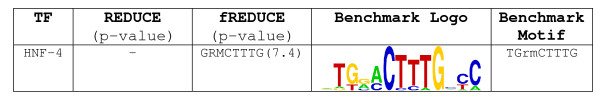
fREDUCE elicitation of the HNF-4 binding site from human hepatocyte expression data.